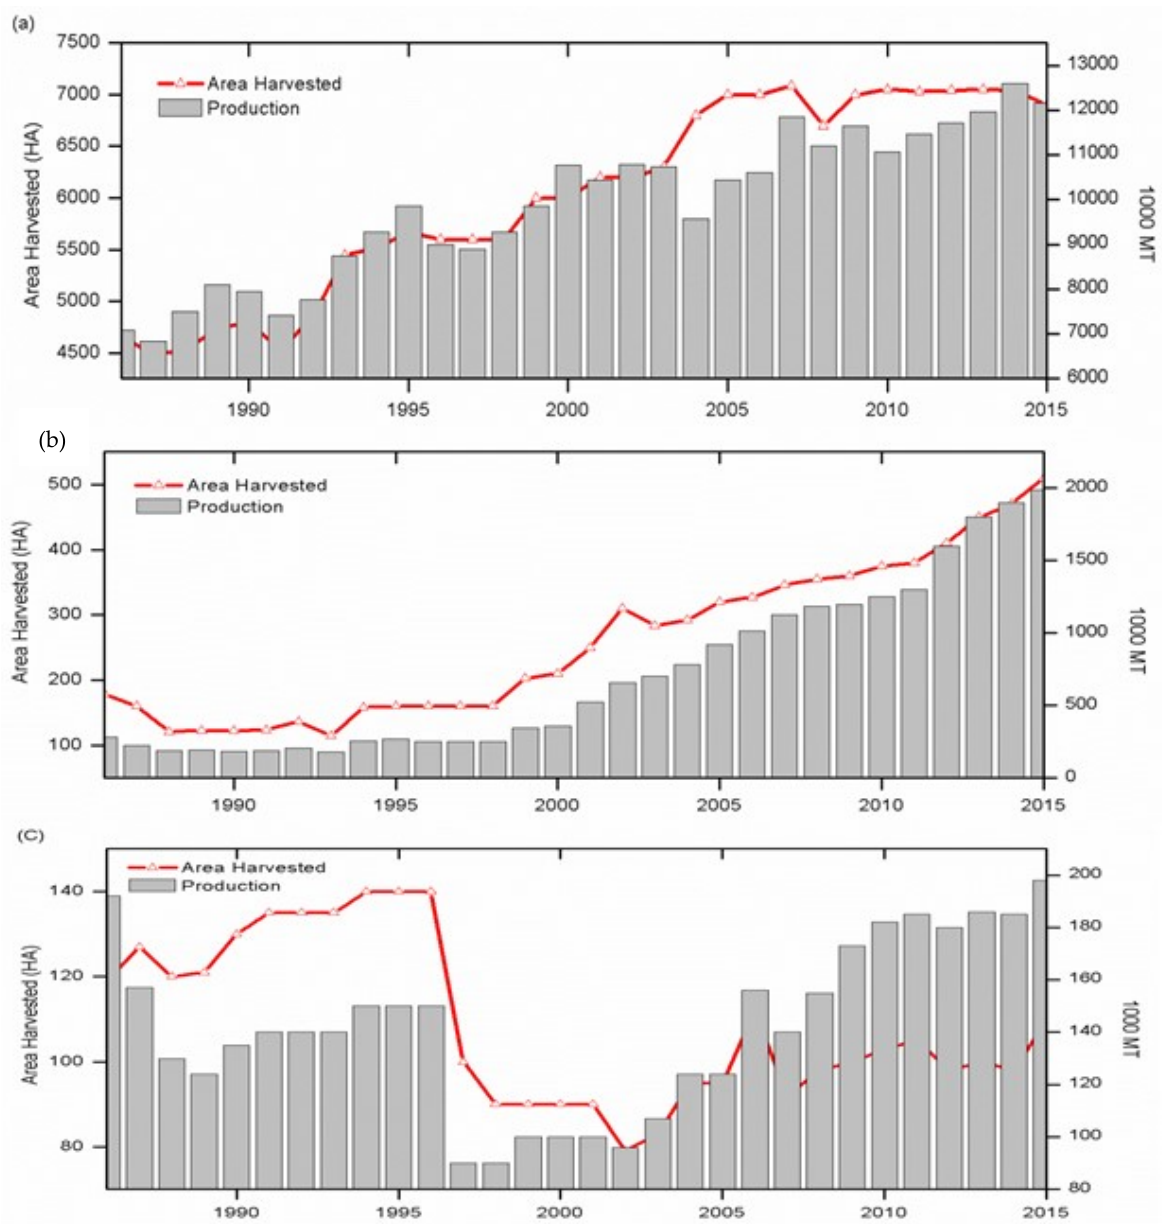
Figure 10. Interannual variability of crop production (1000 MT) and harvested area (HA) for ( a ) Rice ( b ) Corn ( c ) Wheat in Myanmar from 1986-2015.